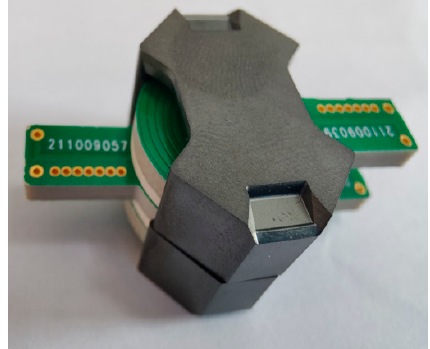
Table 1. Parameters of the third ‐ order band ‐ pass filter.